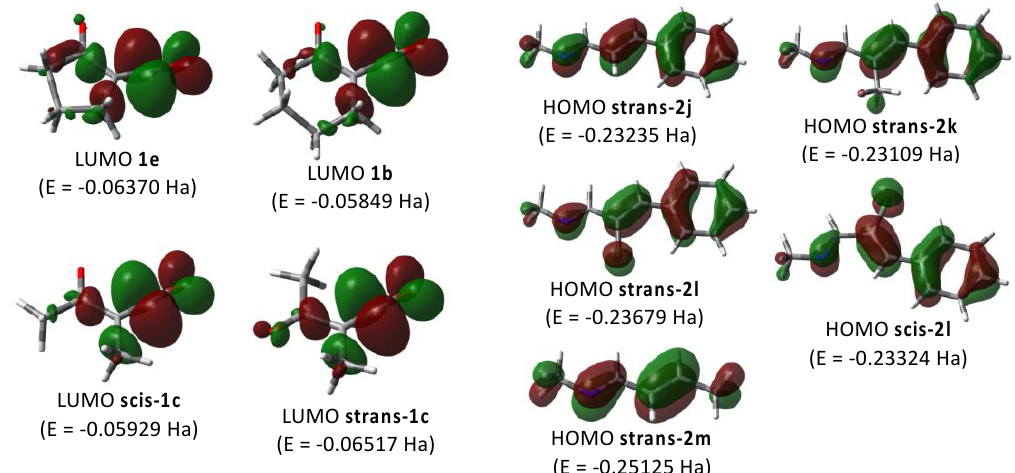
Figure 7. Contour plots of the lowest unoccupied molecular orbitals (LUMOs) in the α-oxoketenes 1e , 1b , scis-1c , and strans-1c , and those of the highest occupied molecular orbitals (HOMOs) of the model 2-azadienes strans-2j , strans-2k , strans-2l , scis-2l , and strans-2m .